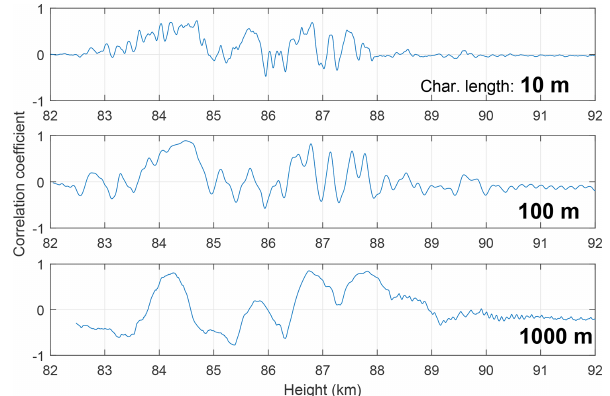
Figure 12. Comparison of correlation between needle Langmuir probe electron density and DUSTY-2B currents. The correlation co- efficients are Spearman rank values for moving windows of three different characteristic lengths: 10, 100, and 1000m. The 10 and 100m components were further filtered to remove spin